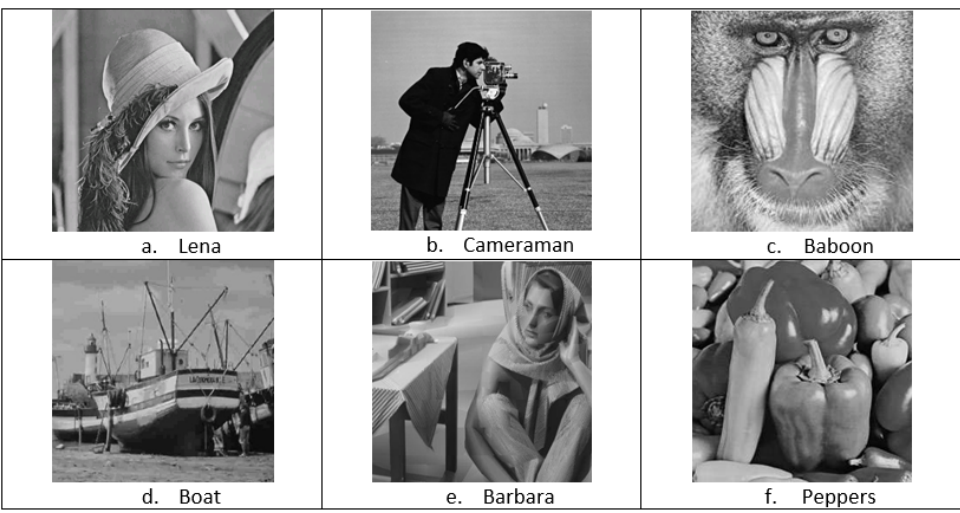
Figure 4. Cover images for watermarking embedding process.